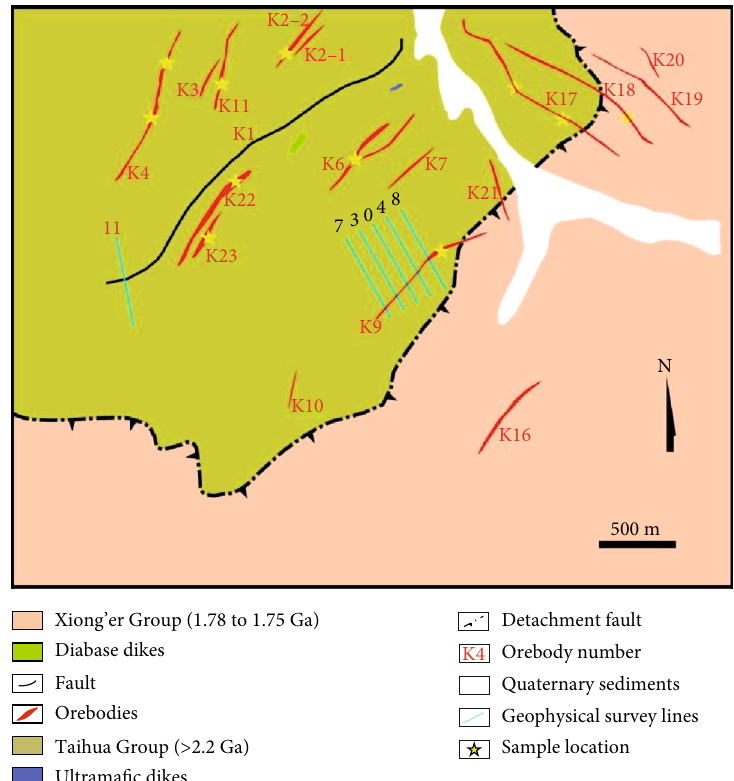
Figure 3: Geologic map of the Longmendian Ag – Pb – Zn